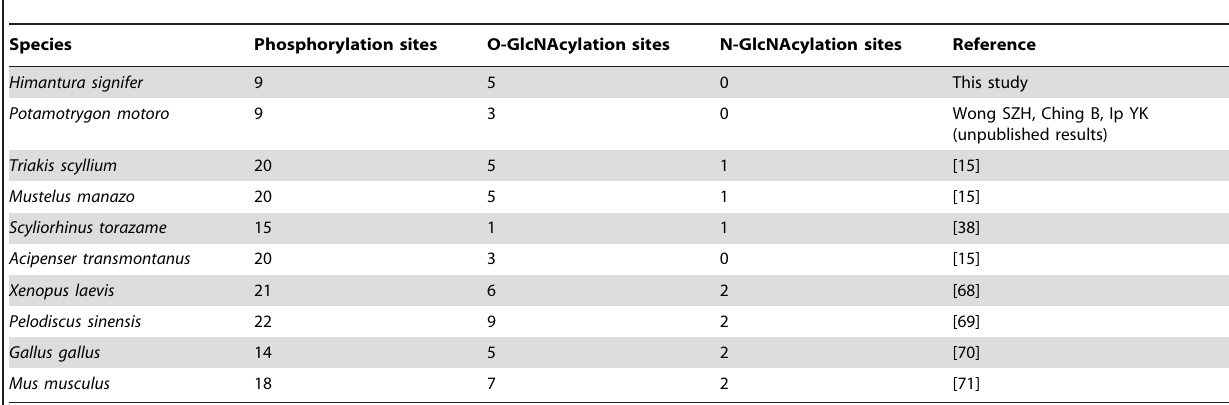
Table 2. Number of phosphorylation, O-GlcNAcylation and N-GlcNAcylation sites in the deduced amino acid sequence of gulonolactone oxidaseof various animals compared with Himantura signifer